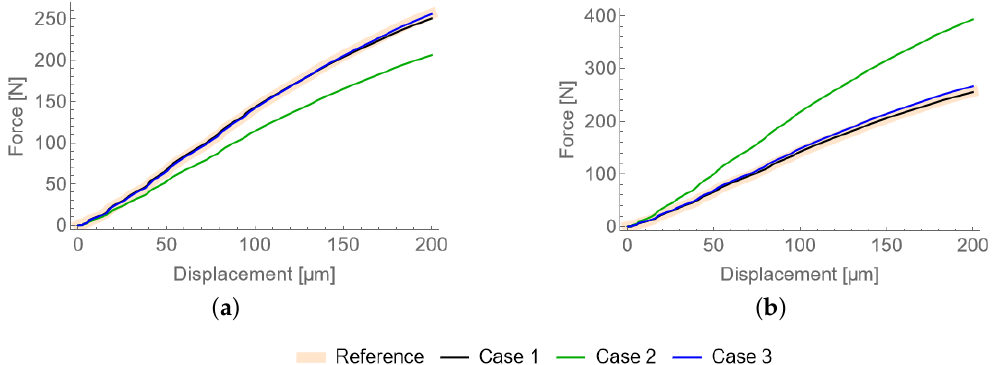
Figure 5. The load–displacement curves obtained in each of the EA runs stating from population Population 1 ( a ) and Population 2 ( b